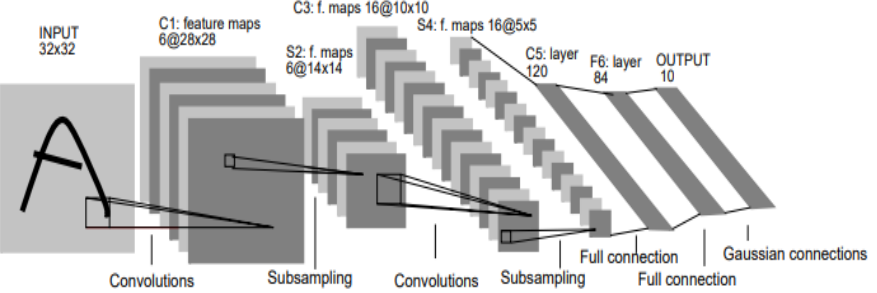
Figure 2. LeNet5 Character Recognition.